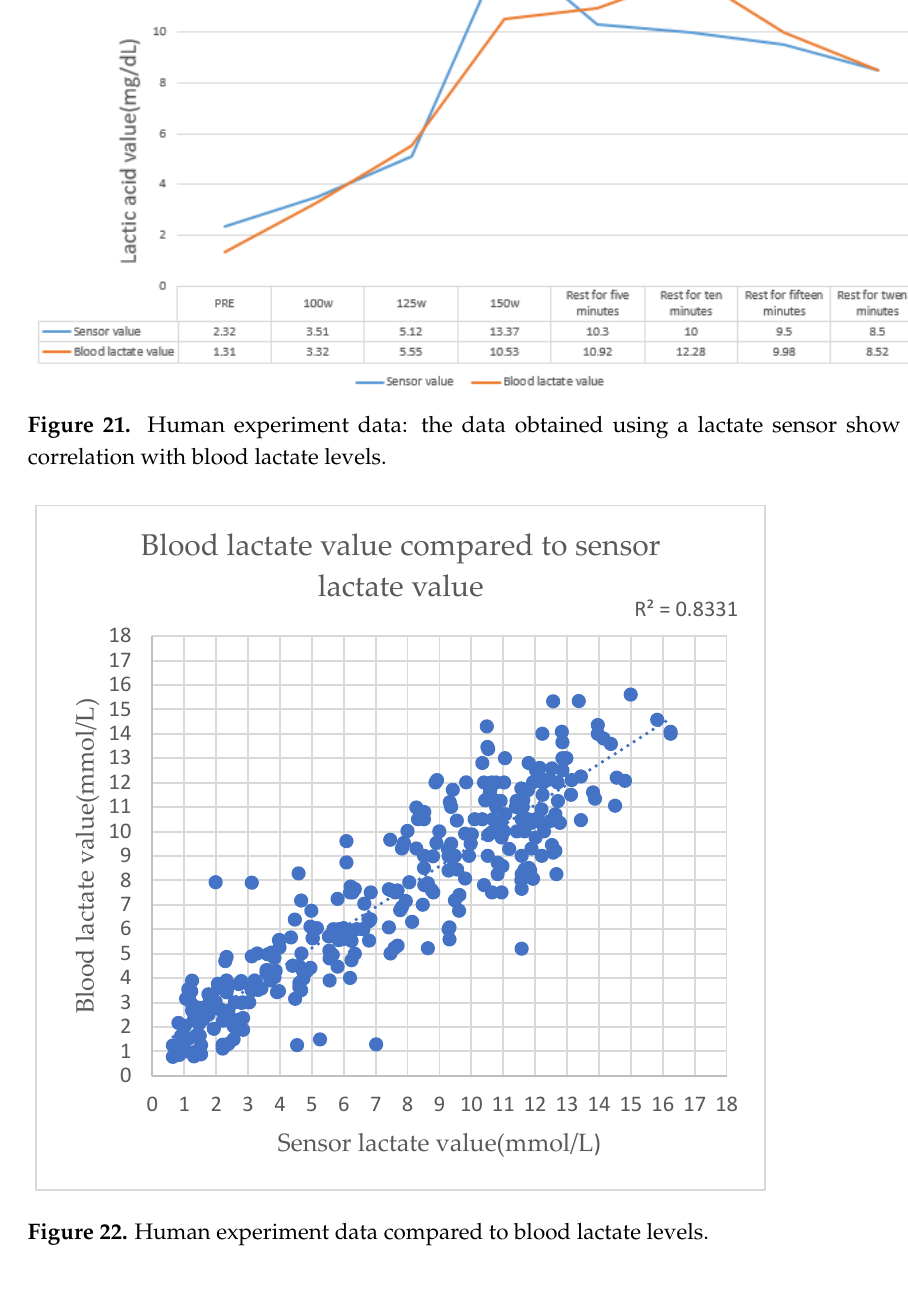
Figure 22. Human experiment data compared to blood lactate